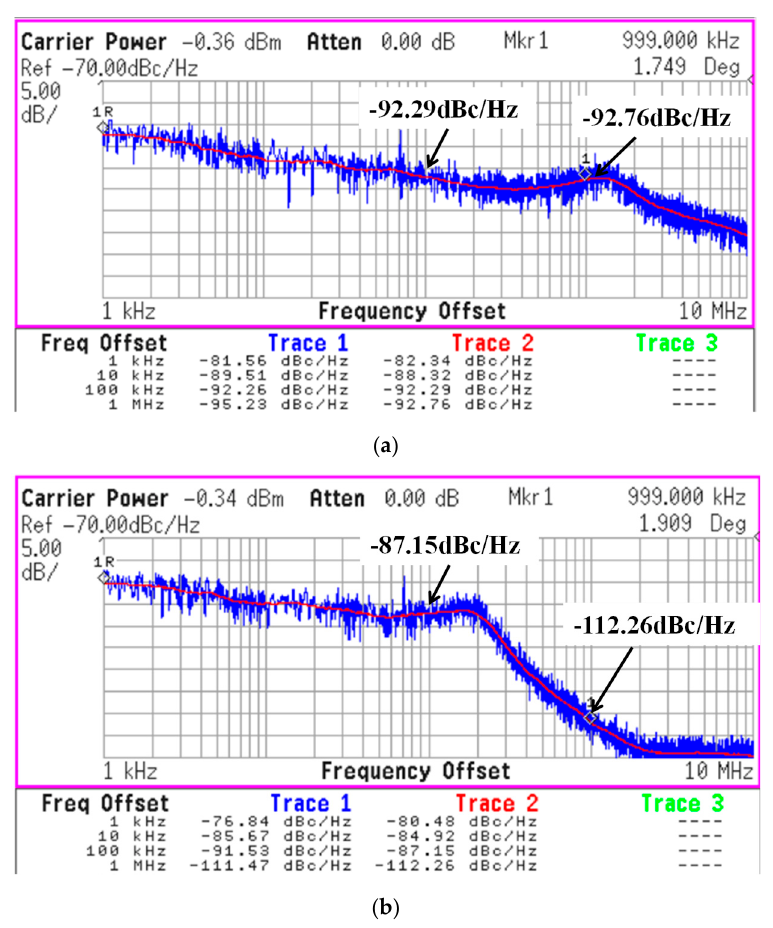
Figure 22. Measured phase noise of the proposed PLL in ( a ) TX mode and ( b ) RX mode.